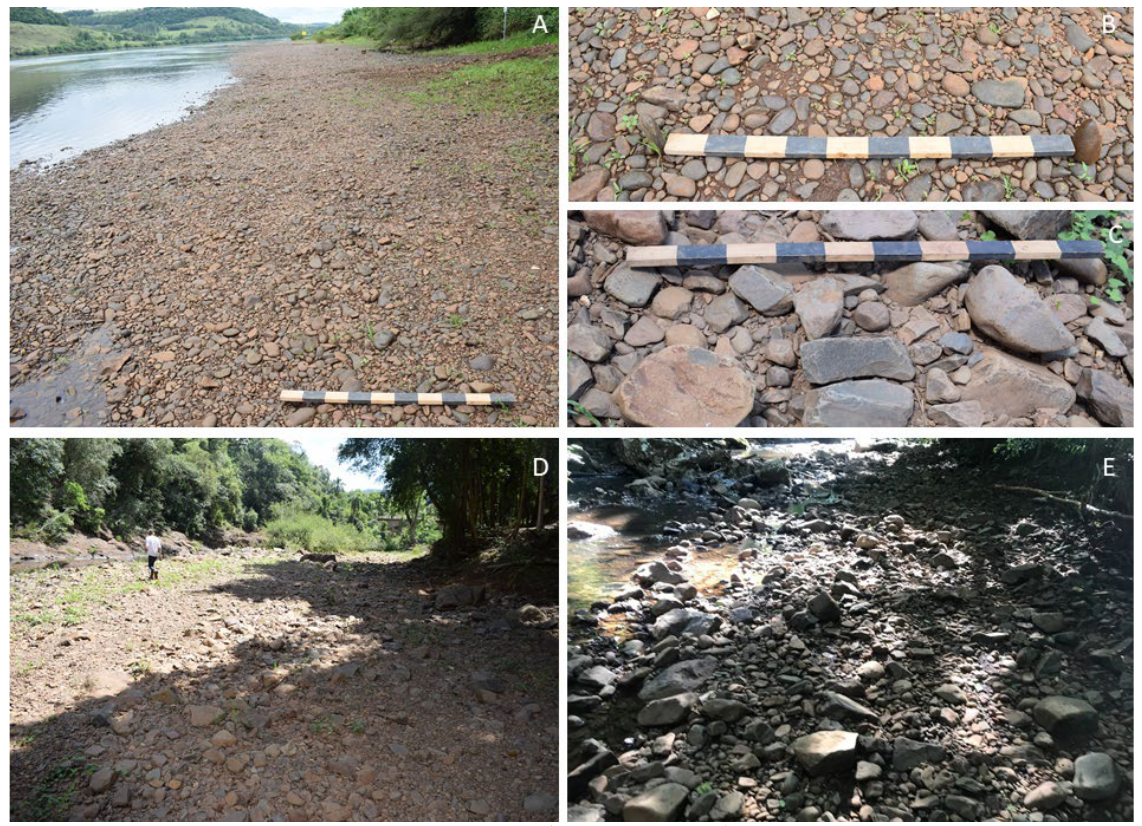
Figure 13. A: Sampled area in the Uruguay River (Palmitos County). B: Detail of the pebbles on the same riverside. C: Detail of pebbles and cobbles in Ariranha River (Arvoredo County). D: Sampled area in the Ariranha River. E: Sampled area in the Taquarussú River (Cordilheira Alta